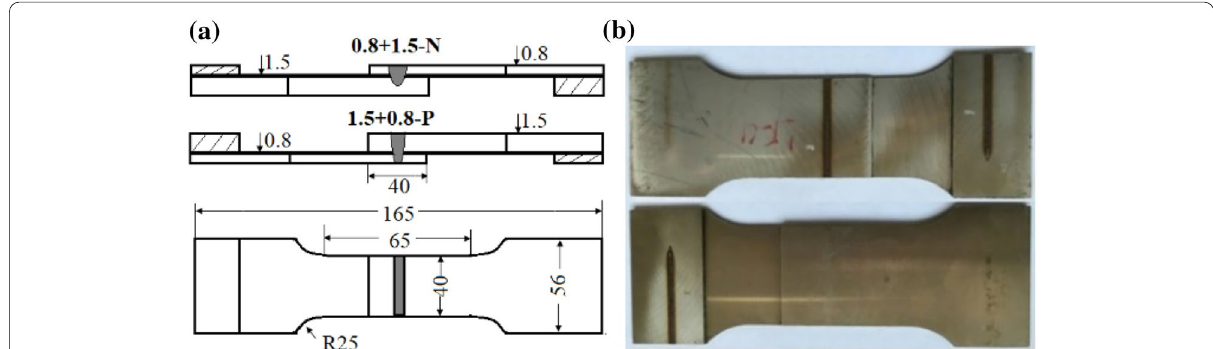
Figure 1 Structure and dimensions (mm) of the specimen: a schematic diagram of penetration 1.5 welded lap joints, b both sides of actual 0.8